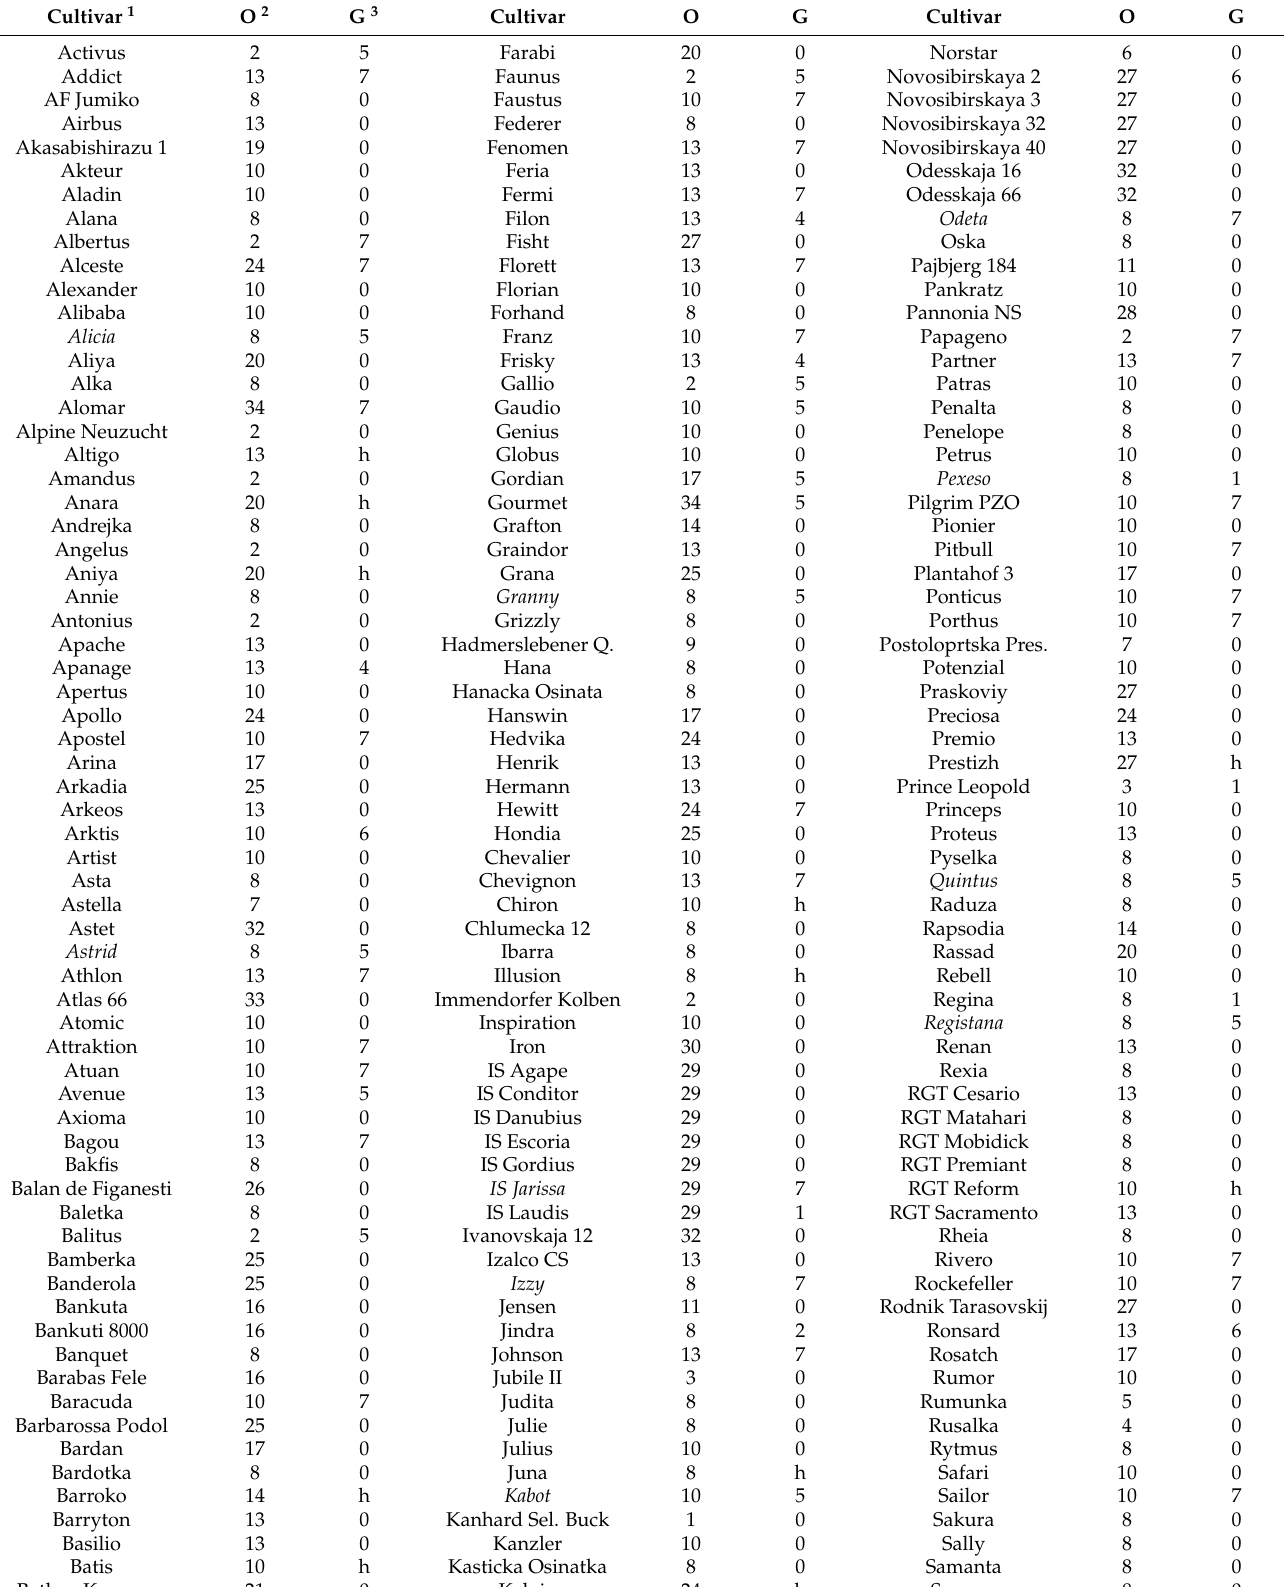
Table 1. Four hundred and forty-eight wheat cultivars, their growth type, country of origin and response to three powdery mildew isolates coded in reverse-octal notation (resistance